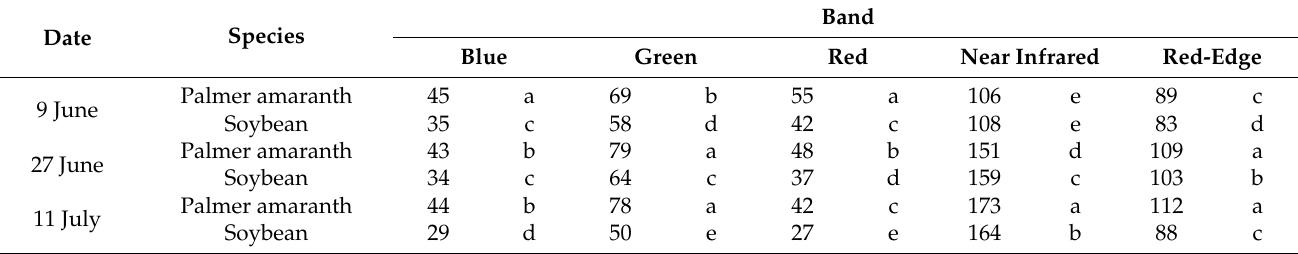
Table 6. Spectral reflectance values of Palmer amaranth and soybean across dates and Palmer amaranth densities from aerial imagery collected from an unmanned aerial vehicle at an altitude of 15 m at Rocky Mount, NC in 2017 (B10). Band Species Blue Green Red Near Infrared